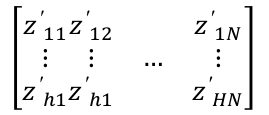
Fig. 4. Detailed view of the chromosome